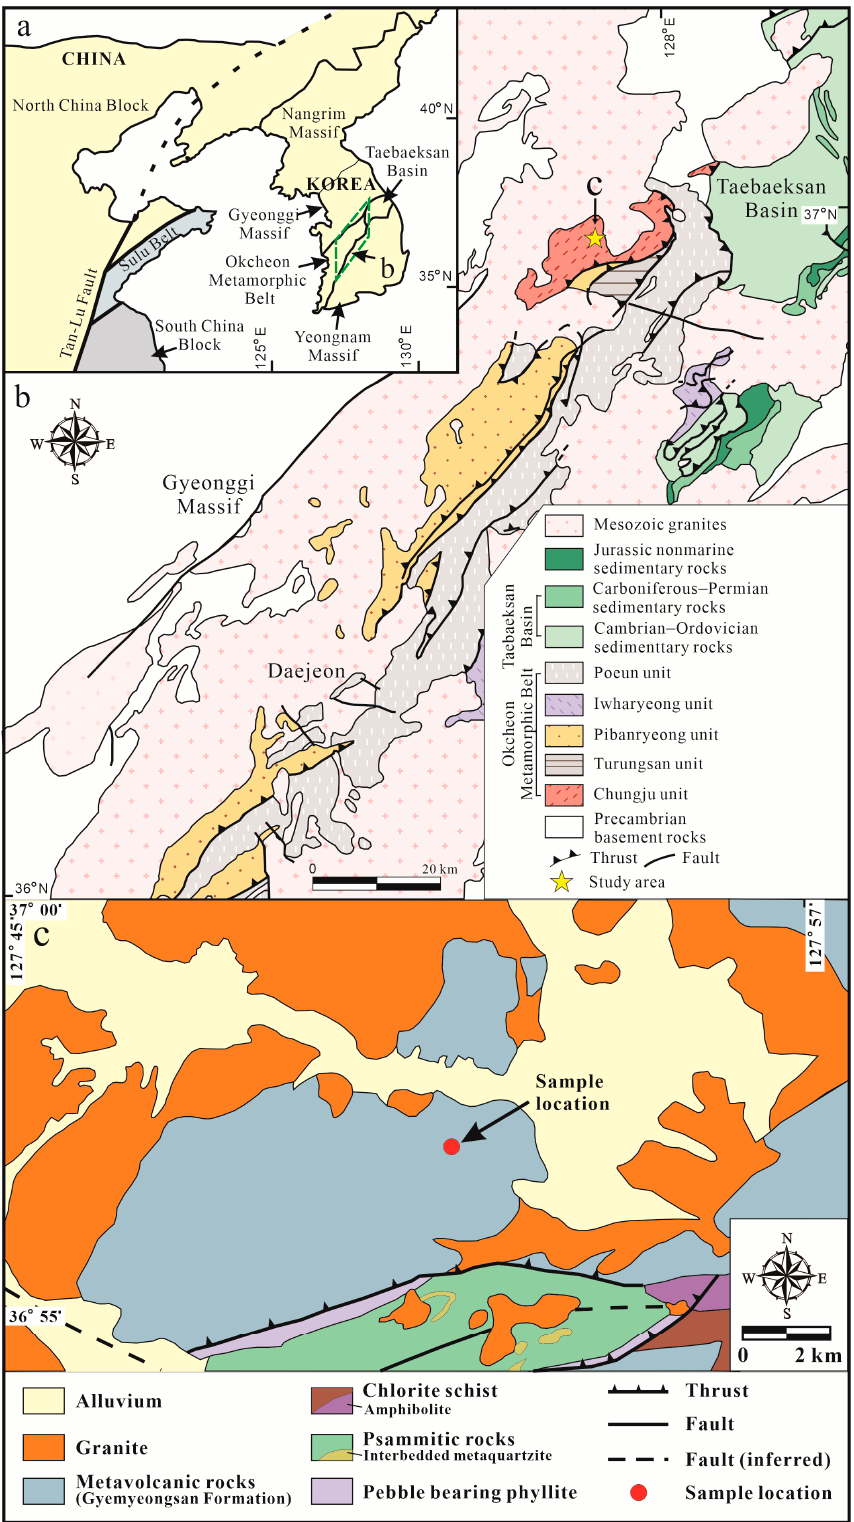
Figure 1. The location of the Chungju deposit and its geological setting. ( a ) A simplified map showing the tectonic provinces of East Asia, including the Korean Peninsula. ( b ) A geological map showing the stratigraphic / lithotectonic units of the Okcheon Metamorphic Belt and the Taebaeksan Basin. ( c ) A geological map of the study area. The figures are modified from reference [9].